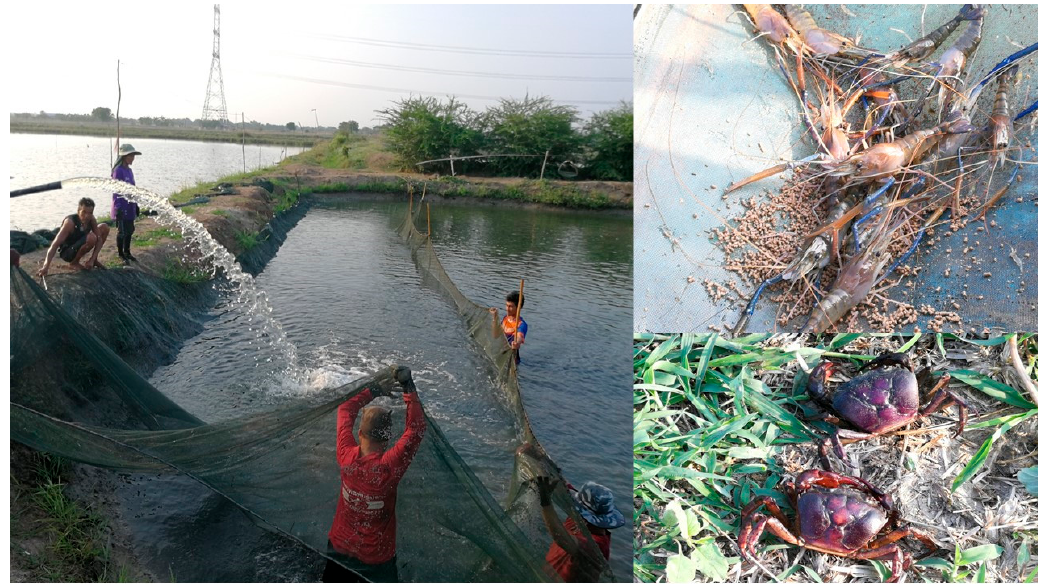
Figure 4. The local people at Nong Teen Nok are collecting prawns for sales and some crabs for personal use in the pond. Source: first